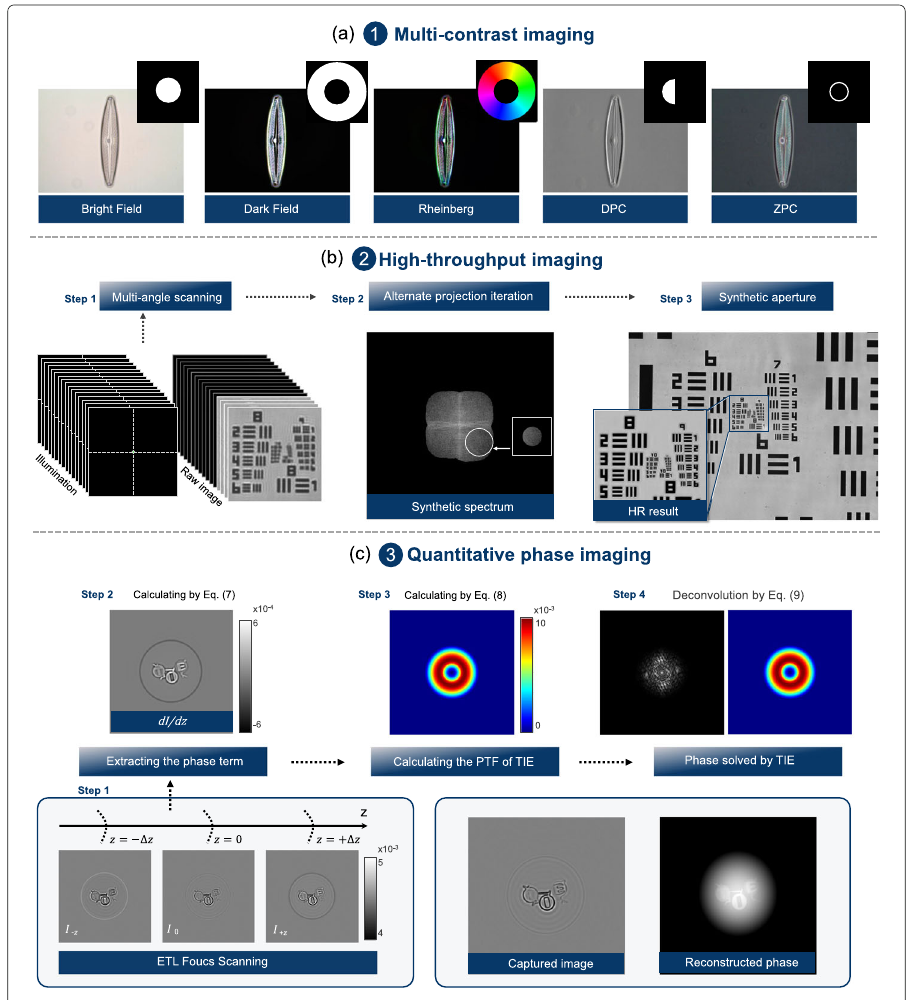
Fig. 12 Technical roadmap for MQP-SCLM. (a) Multi-contrast imaging including bright field, dark field, Rheinberg optical staining, DPC, and ZPC. (b) High-throughput imaging based on FPM. (c) QPI based on